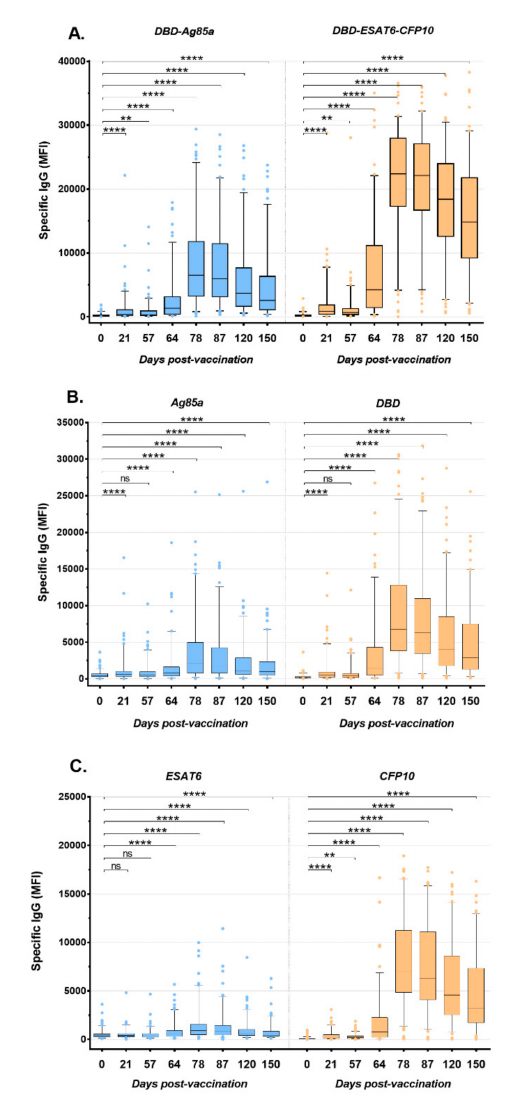
Figure 3. IgG antibody profiles after the immunization with GamTBvac specific to DBD-Ag85a and DBD-ESAT6-CFP10 ( A ), and individual vaccine components ( B , C ) in the group of vaccine recipients. ** p < 0.01, **** p < 0.0001, ns—not